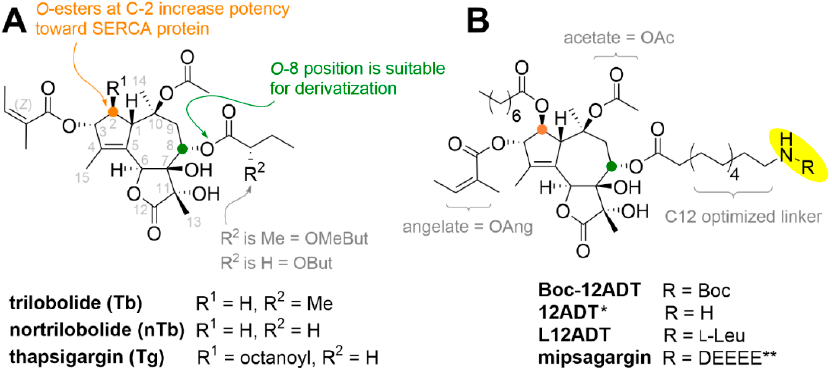
Figure 1. Molecular structures of thapsigargins (Panel A ) and structures of researched thapsigargin (Tg) derivatives (Panel B ). * 8- O -(12-aminododecanoyl)-8- O -debutanoyl- Tg ; ** DEEEE = β -L-Asp- γ - (L-Glu) 4 -OH.